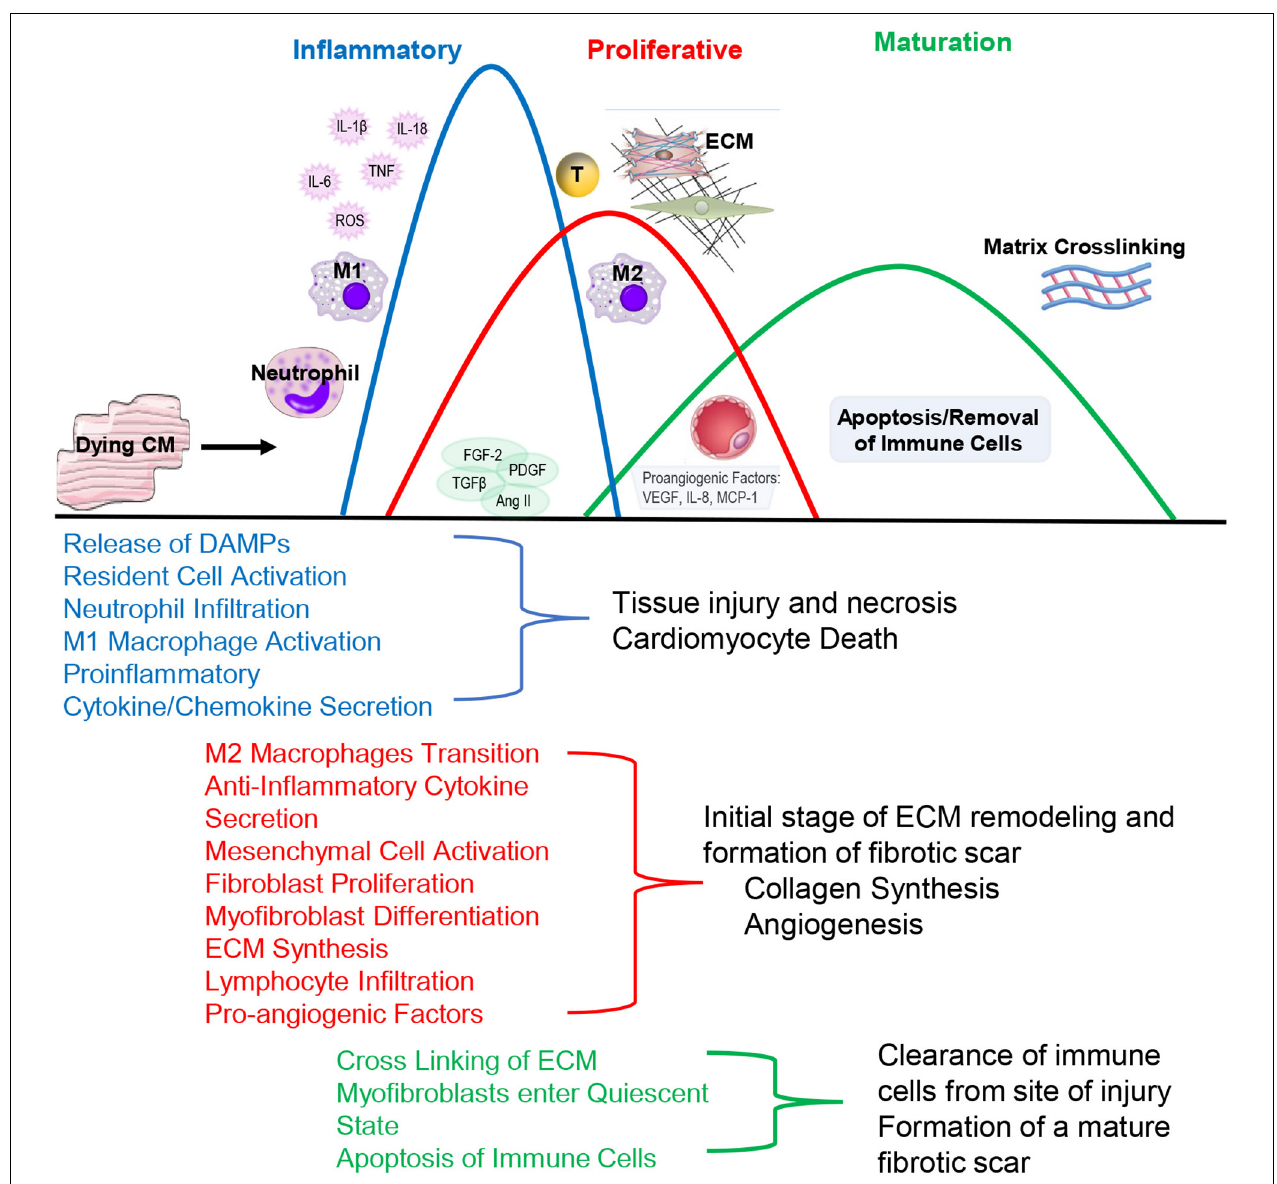
FIGURE 2 | During the Inflammatory Phase, damage or death of cardiomyocytes activates resident fibroblasts and other cell populations to produce cytokines and recruit pro-inflammatory leukocyte populations, primarily neutrophils and monocytes that differentiate into M1-like macrophages. This acute, pro-inflammatory response transitions into a reparative response during the Proliferative Phase with the recruitment of reparative lymphocyte and M2-like macrophages populations. Activated myofibroblasts secrete collagen and other extracellular matrix components. Pro-angiogenic factors are secreted that promote neovascularization. The events conclude during the Maturation Phase with the apoptosis of reparative immune cell and myofibroblast populations and matrix crosslinking, resulting in mature scar